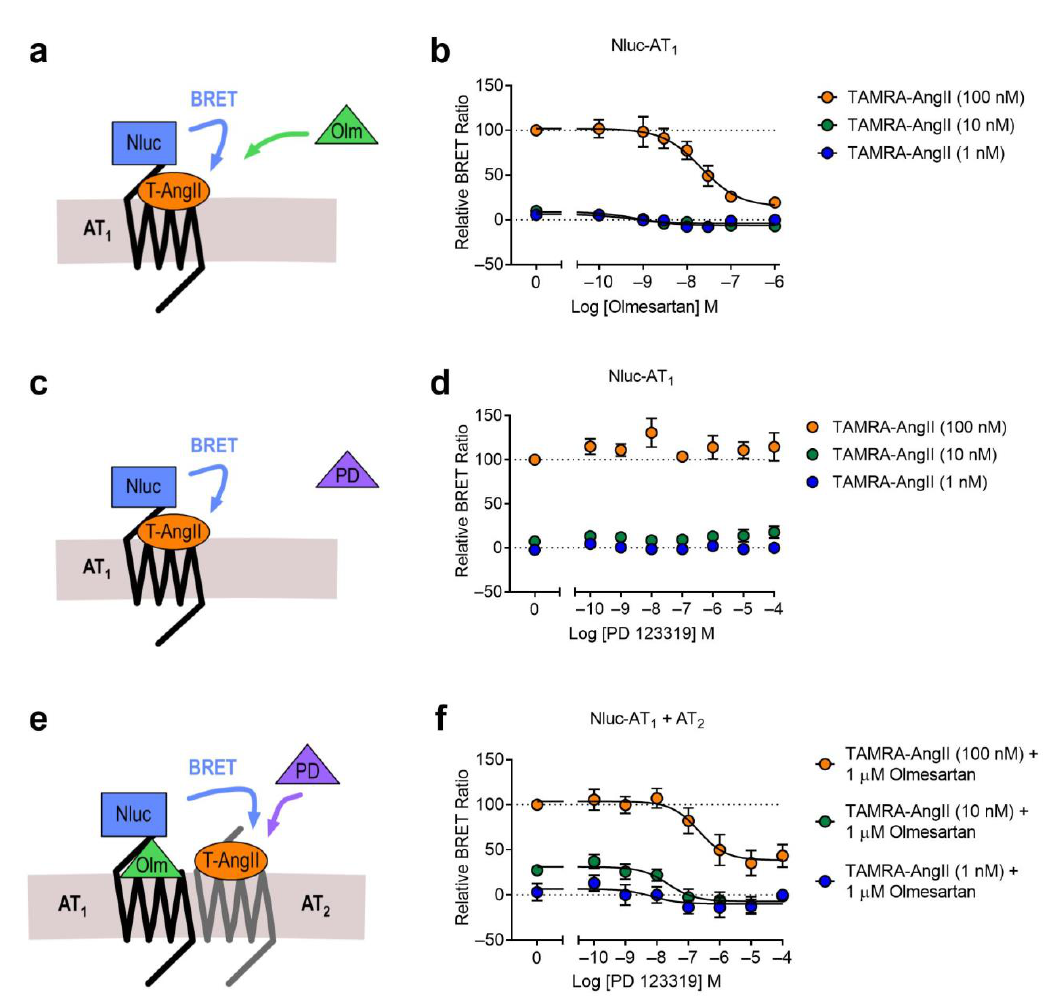
Figure 8. Competition binding of TAMRA-AngII to the AT 1 receptor and the AT 1 -AT 2 heteromer. Cells expressing Nluc-AT 1 and treated with various concentrations of TAMRA-AngII (T-AngII) as stated, with increasing concentrations of olmesartan (Olm) ( a , b ). Cells expressing Nluc-AT 1 and treated with various concentrations of TAMRA-AngII as stated, with increasing concentrations of PD 123319 (PD) ( c , d ). Cells expressing Nluc-AT 1 and untagged AT 2 and treated with 1 µ M olmesartan, various concentrations of TAMRA-AngII as stated, and increasing concentrations of PD 123319 ( e , f ). Data are normalized (100% being 100 nM TAMRA-AngII treated with no competitor present and 0% being 1 nM TAMRA-AngII treated at maximum competitor concentration) and displayed as relative BRET ratio, mean ± SEM of three independent experiments.